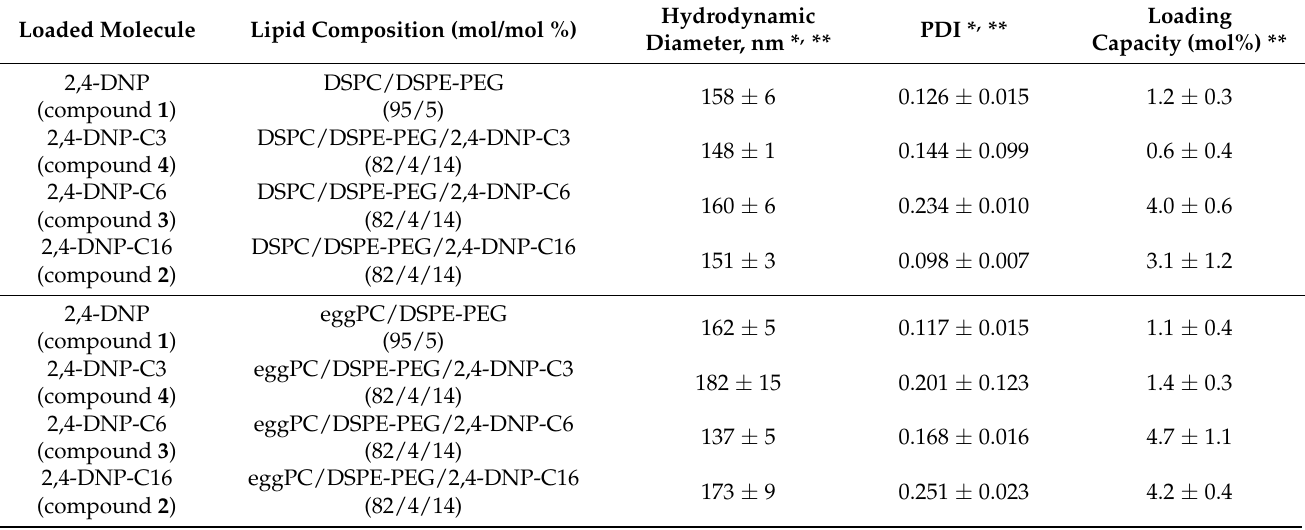
Table 4. Characteristics of liposomal formulations of 2,4-DNP